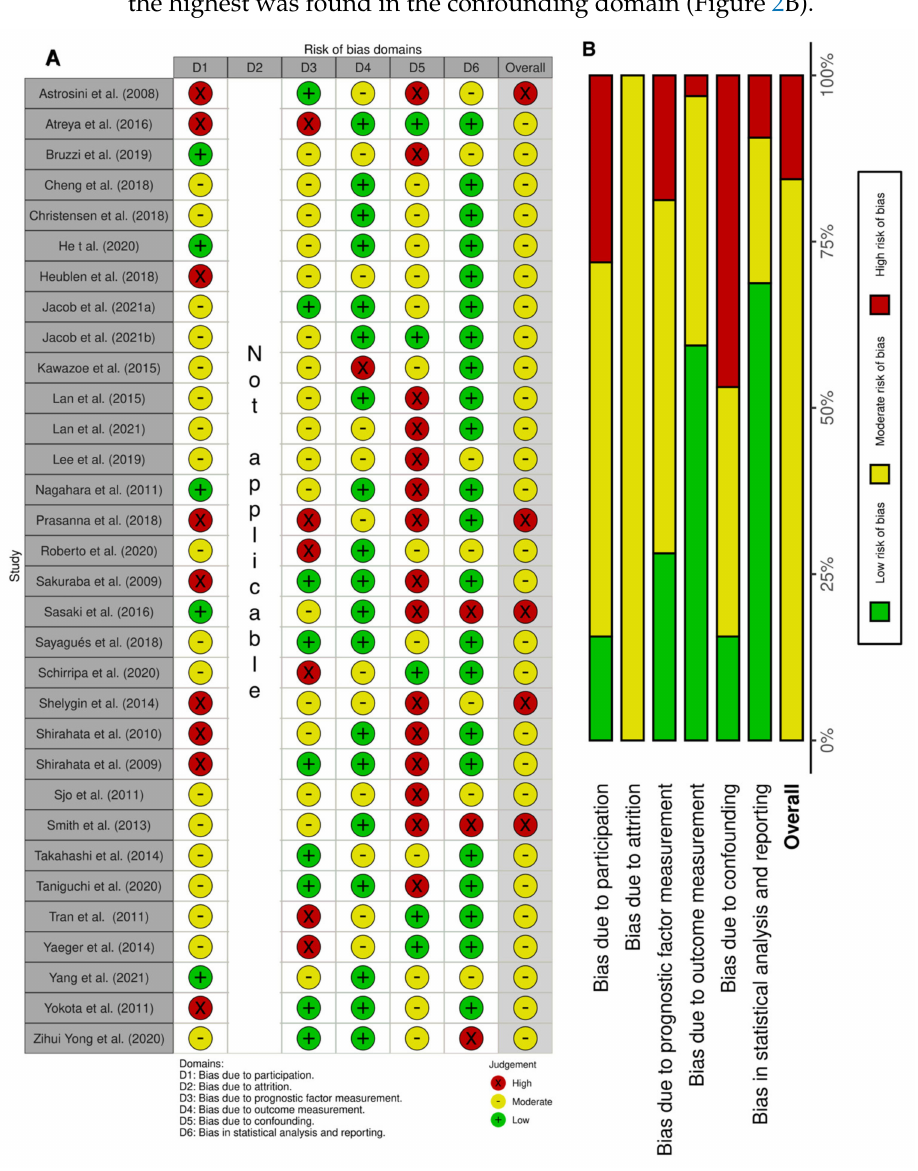
Figure 2. Risk of bias based on the QUIPS tool. ( A ) Summary of the domain–level judgements for each study. ( B ) Risk–of–bias judgements within each bias